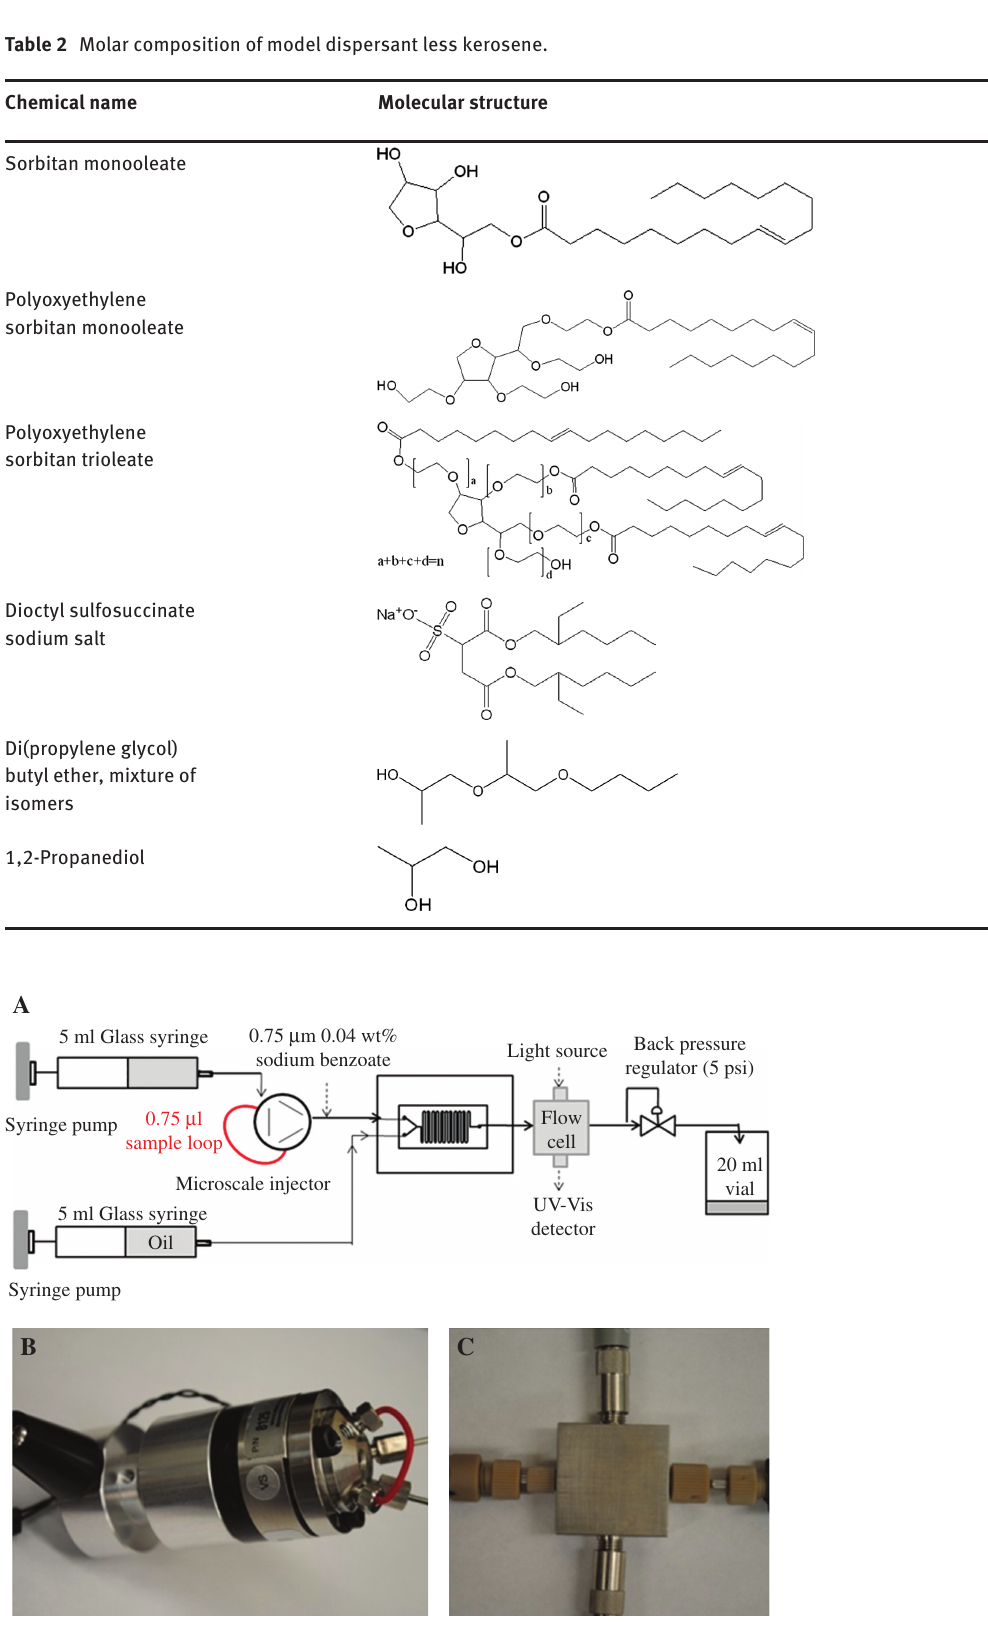
Figure 2 (A) Schematic diagram of continuous inline UV-vis spectroscopy used for RTD measurements. (B) Microscale injector with a 0.75- µl sample loop (6 cm of 0.005” ID red tubing) and (C) flow cell with integrated 400-µm ID quartz